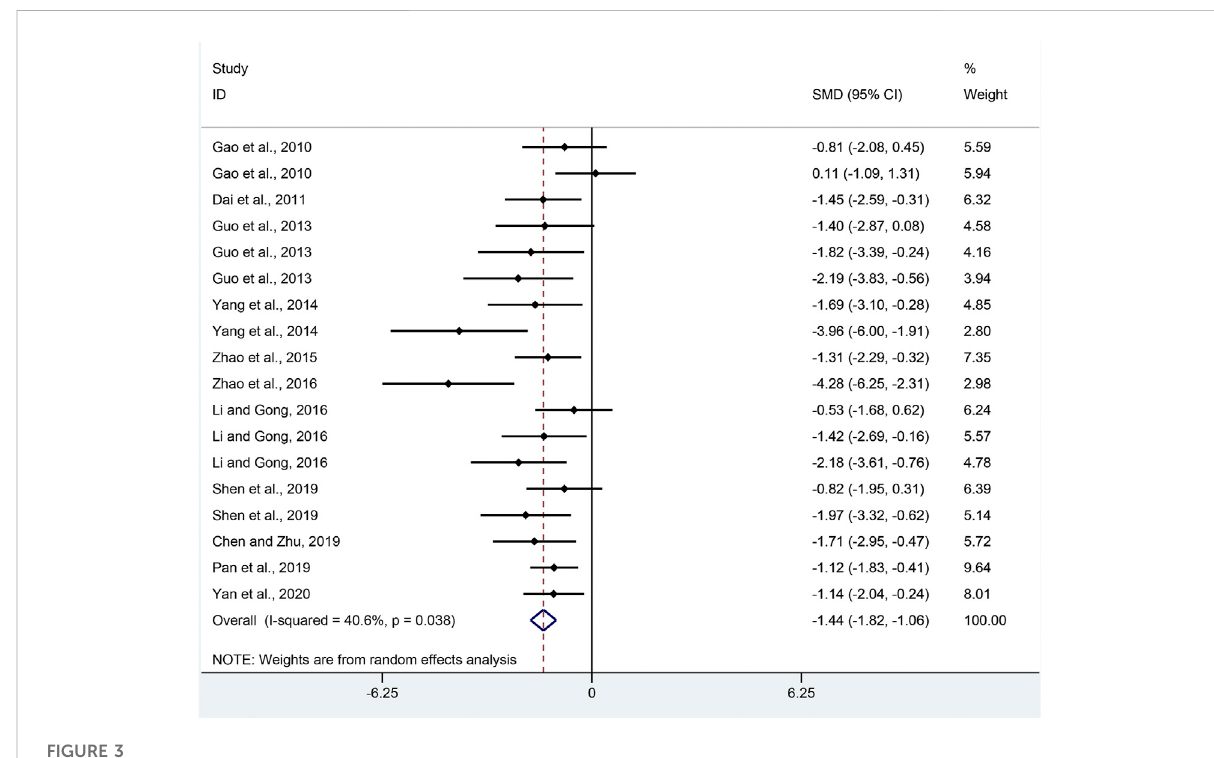
FIGURE 3 Pooled estimate of CMDI with